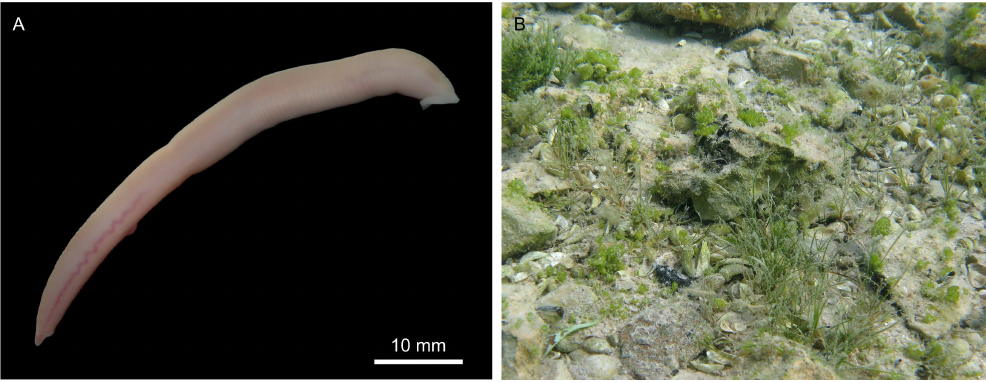
Fig. 1. (A) Live specimen of endemic Dina lyhnida from Lake Ohrid, a species that occurs from the lower littoral to the profundal. (B) Habitat photograph of the lower littoral zone of Lake Ohrid near Veli Dab. In Lake Ohrid, the lower littoral is the zone with the highest total leech density (Sket, 1992).